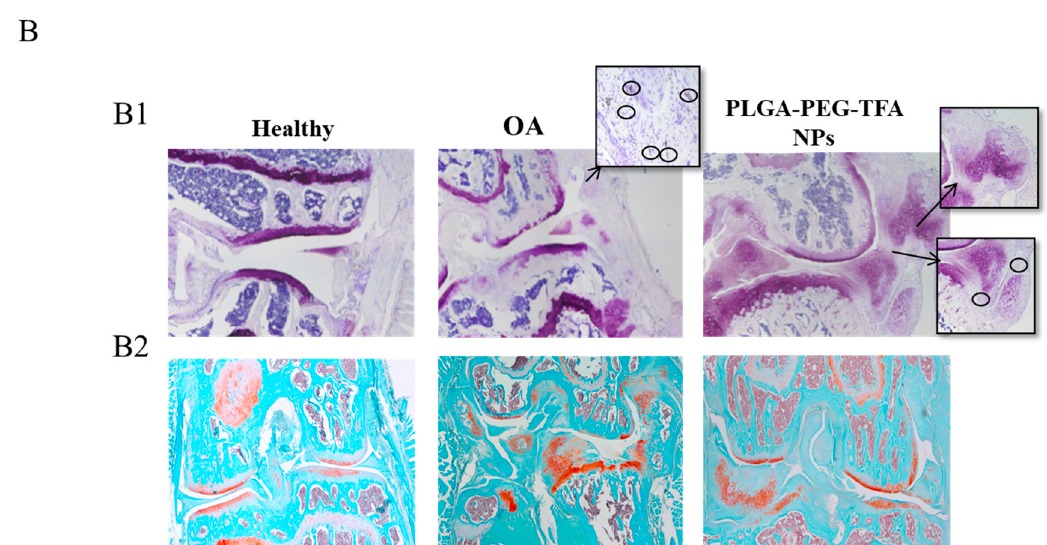
Figure 7. Representative images of PLGA-PEG-TFA NPs in ex vivo. ( A ) Ex vivo 19 F-MRI images in axial, coronal and sagittal view of the right knee. The image was taken at 2, 48, and 168 h post-NP injection. Red shows the signal of TFA present on the surface of PLGA-PEG-TFA NPs. ( B ) Histological staining images. From left to right healthy knee (negative control), osteoarthritis (OA) knee without NPs treatment (positive control), representative pictures of OA knee treated with PLGA-PEG-TFA NPs. ( B1 ) Hematoxylin/Eosin and F4/80 staining, macrophages are indicated with the black circle. ( B2 ) Histological staining with Safranin-O fast green.